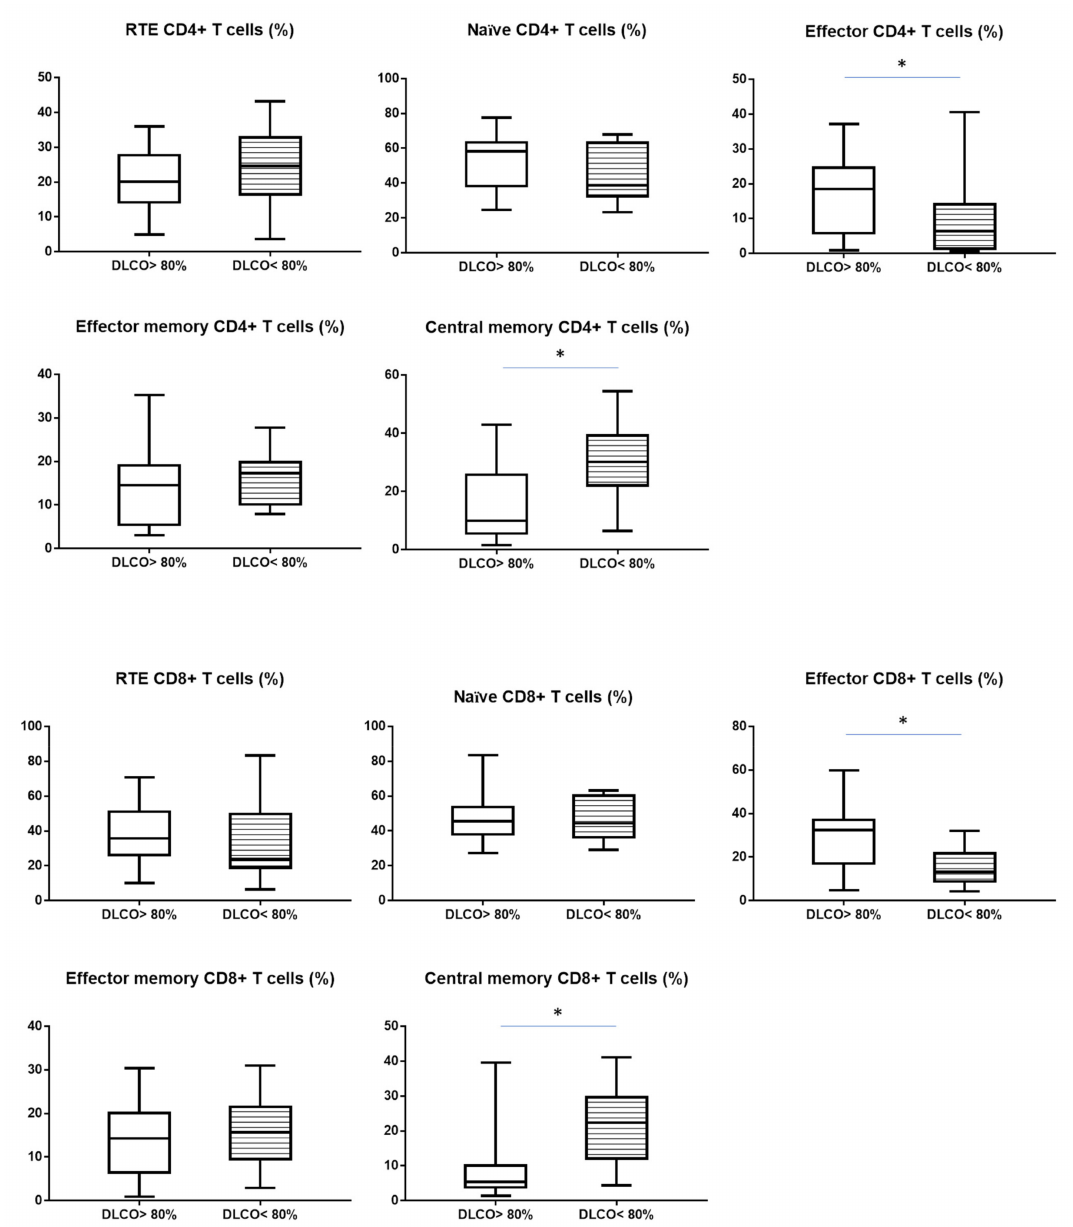
Figure 2. The differences in the median proportion of T CD4+ and CD8+ lymphocytes subsets: Recent thymic emigrants T cells (RTE), naïve T cells, effector T cells, central memory T cells and effector memory T cells between sarcoidosis patients with normal diffusion: DLCO > 80% (without stript) and with reduced diffusion: DLCO < 80% (with stript). Graphs show the median values and max-min (* p < 0.05 statistically